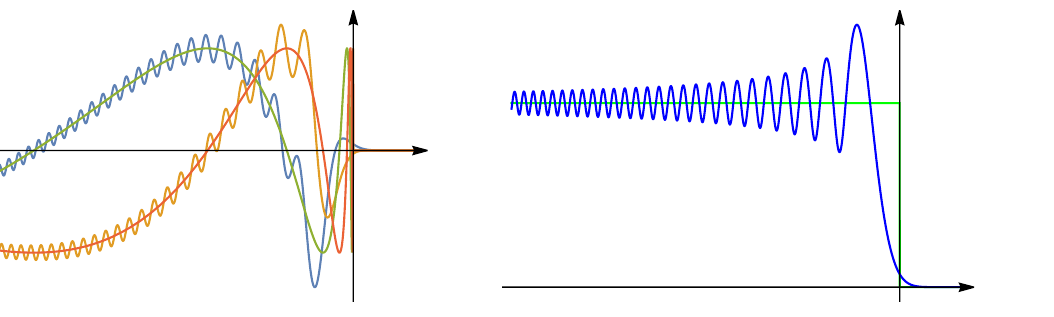
Figure 2. Real and imaginary parts of ψ ( U, V 0 ) and ψ ( U, V 1 ) . ψ ( U, V 0 ) appears as small pertur- bations of ψ ( U, V 1 ) with ever higher frequencies in the − U direction.